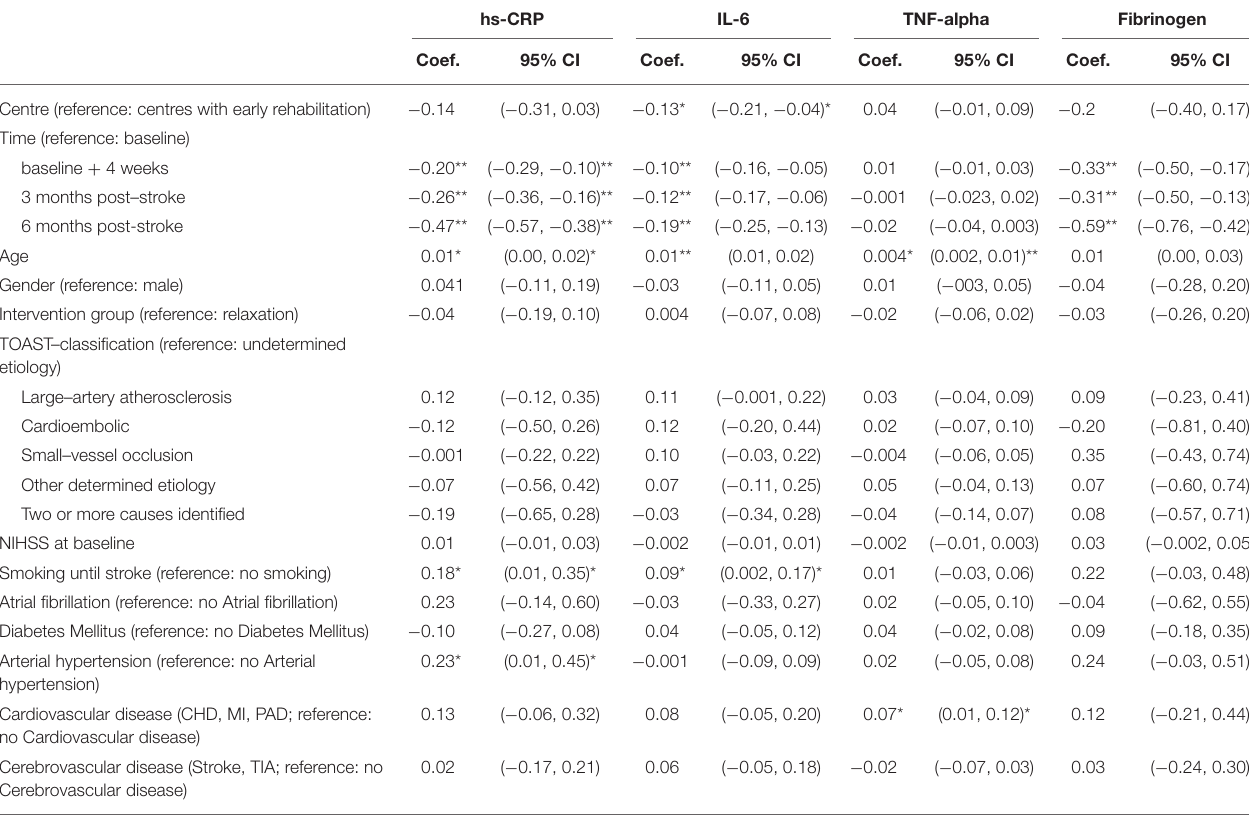
TABLE 2 | Factors associated with levels of inflammatory biomarkers over time; GEE-models. hs-CRP IL-6 TNF-alpha Fibrinogen Coef. 95% CI Coef. 95% CI